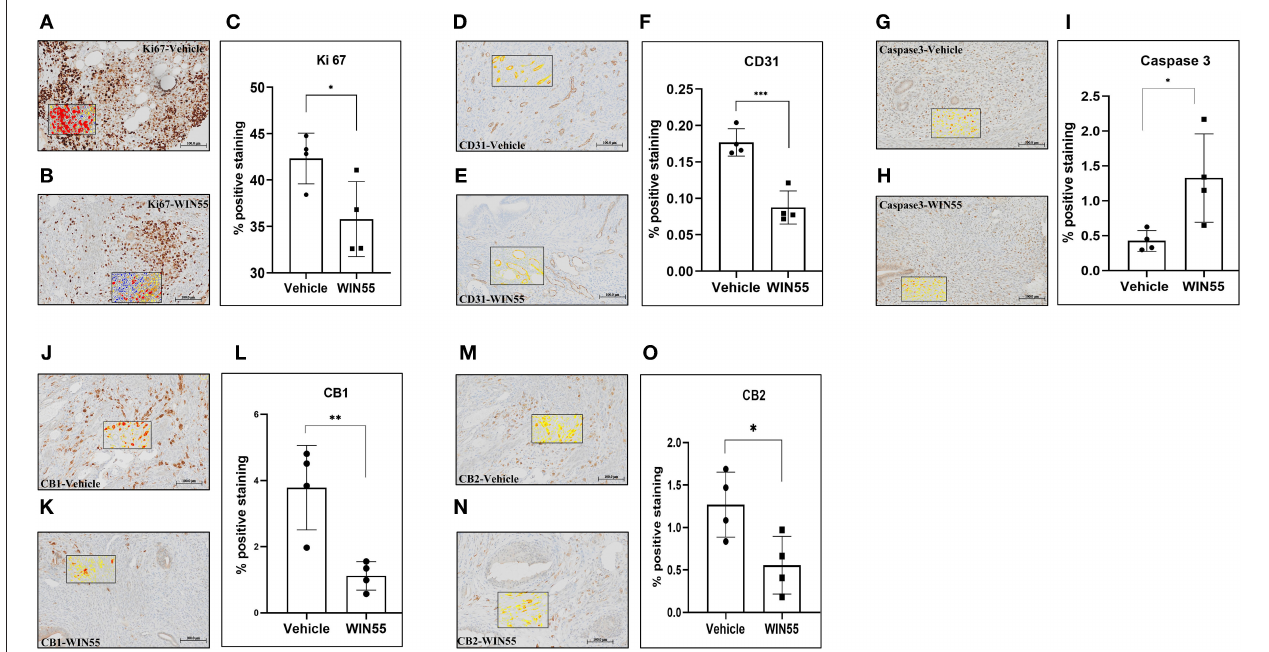
FIGURE 4 | Chronic exposure of WIN 55 in endometriosis (EM) induced mice attenuates lesion growth and vascularization. Immunocompetent C57Bl/6N mice were induced with EM and treated with 14 doses of WIN 55 (1mg/kg i.p) before euthanasia on day 28. Lesions recovered from vehicle, and WIN 55 treated mice were analyzed for hallmarks of EM, such as proliferation and angiogenesis. Representative IHC images of Ki-67 (A,B) (marker of proliferation), CD31 (D,E) (marker of vasculature), Caspase-3 (G,H) (marker of apoptosis), CB1 (J,K) , and CB2 (M,N). Lesions from mice that were subjected to chronic exposure of WIN 55 showed a significant reduction in tissue proliferation (C) and angiogenesis (F) , while caspase activity was significantly increased (I) , which indicates heightened apoptosis. Cannabinoid receptors CB1 (L) and CB2 (O) also showed reduced expression in these lesions compared with the group treated with vehicle. The black box within the IHC images represents the analysis used in this study, where yellow, orange, and red denotes weak, mild, and strong staining, respectively. Scale bar 100 µ m. Non-parametric unpaired student’s t -test. * P < 0.05 ** P < 0.01 *** P < 0.001.